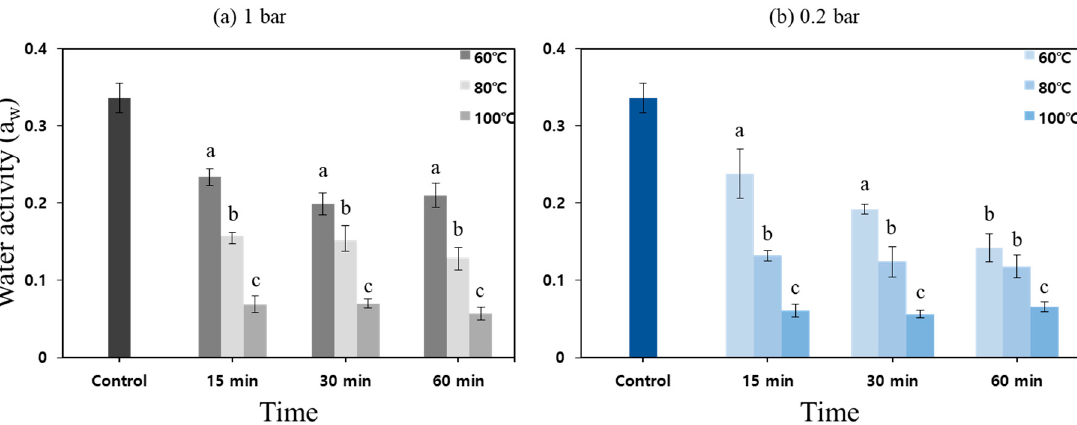
Figure 11. The change in water activity of the sprout barley powder by pressure (( a ) 1 bar, ( b ) 0.2 bar), treatment time (15, 30 and 60 min), and heating temperature (60, 80 and 100 ◦ C). Different letters indicate significant differences ( p <